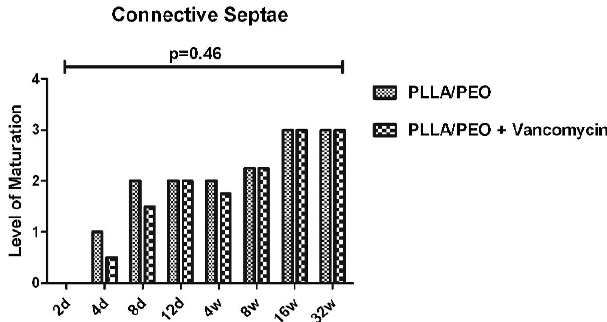
Figure 5 - Level of maturation of the connective septae formed around the microspheres (1=loose connective tissue, 2=dense connective tissue, 3=connective tissue with partial ossification and 4=total ossification). The periods that showed no values are equivalent to 0=absent.